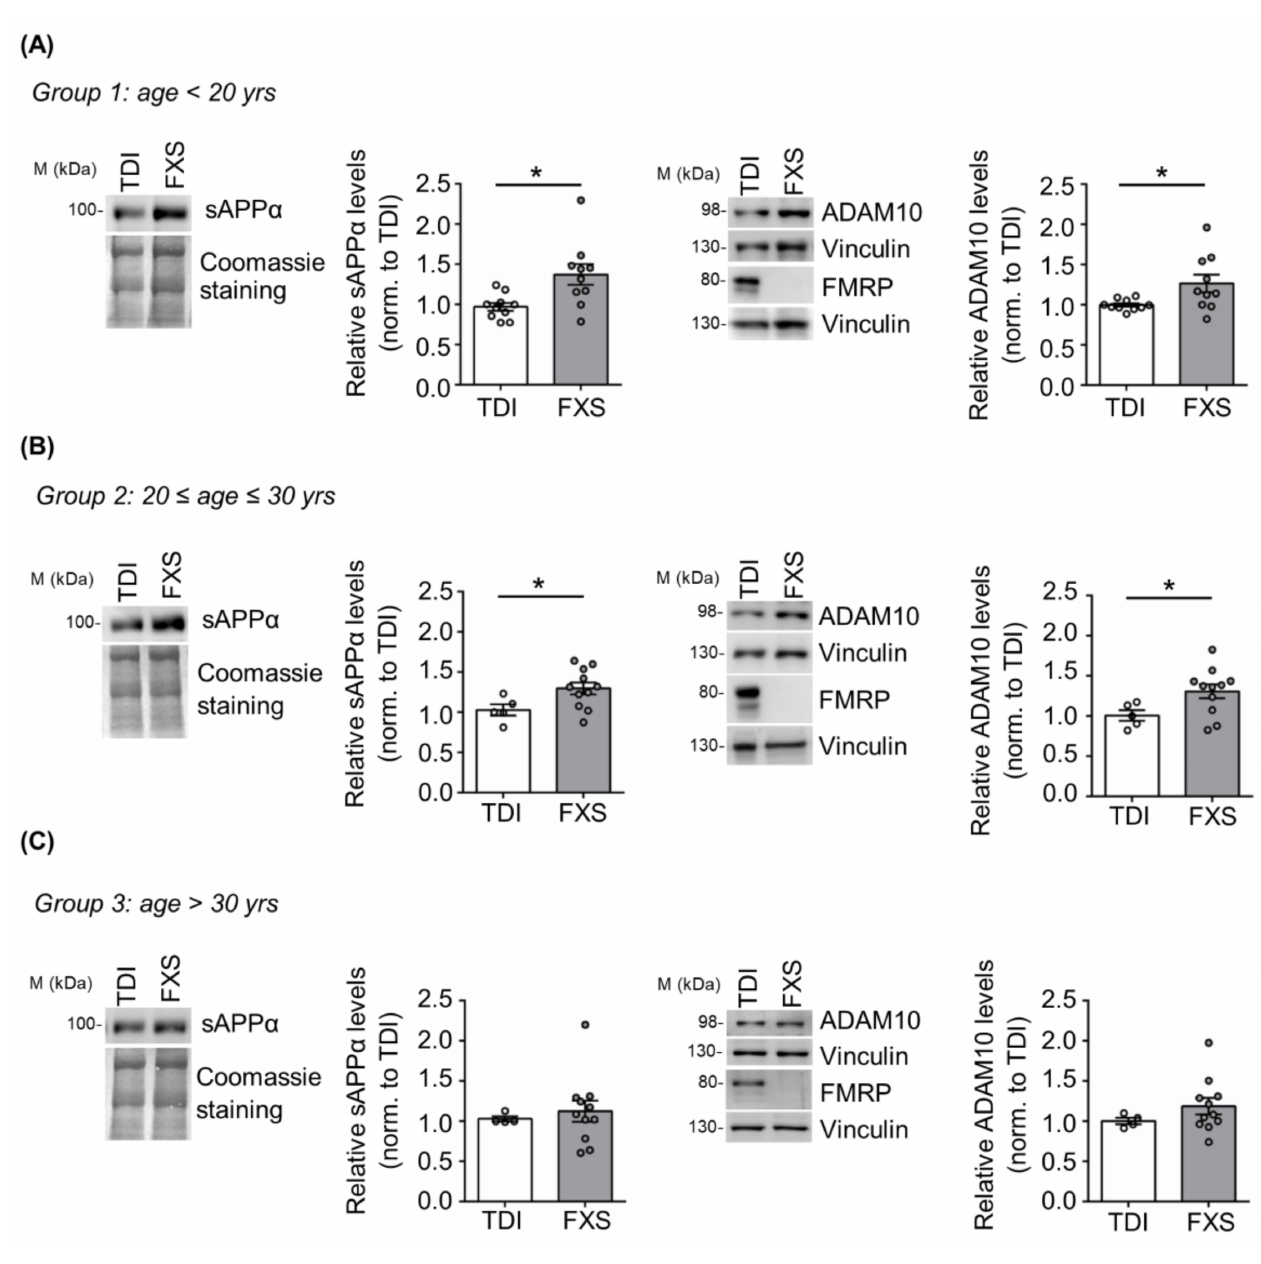
Figure 1. APP processing in human TDI and FXS fibroblasts. Representative Western blot showing sAPP α , ADAM10, and FMRP in TDI and FXS individuals stratified according to the age: ( A ) <20 years (TDI n = 10; FXS n = 10), ( B ) between 20 and 30 years (TDI n = 5; FXS n = 11) and ( C ) >30 years old (TDI n = 4; FXS n = 11). The bar plots show the quantification of sAPP α and ADAM10 levels in TDI and FXS fibroblast cell lines normalized to Coomassie staining and Vinculin, respectively. Error bars represent the SEM (* p < 0.05, Mann–Whitney test). ADAM10 and FMRP proteins were detected on separate blots, each with its own control